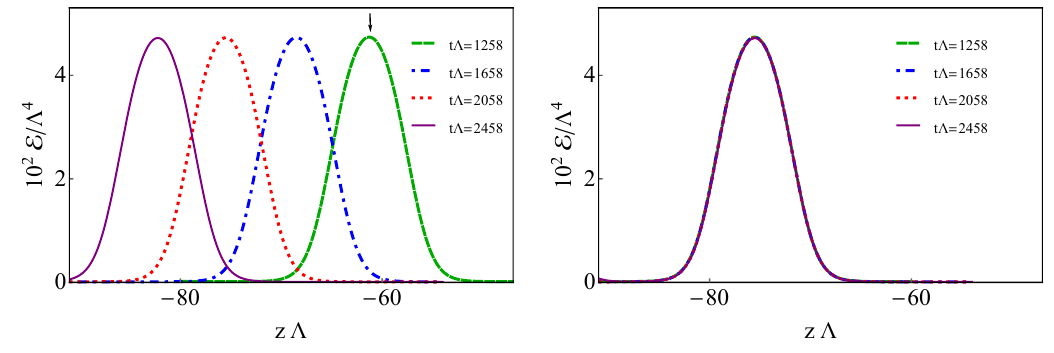
Figure 12 . (Left) Pro(cid:12)le of one of the peaks in (cid:12)gure 4 at di(cid:11)erent times. The peak indicated by an arrow is the same as the one indicated by an arrow in (cid:12)gure 8(left) and (cid:12)gure 11(left). (Right) The same pro(cid:12)les as in (Left) shifted by a constant amount to show that the peak moves